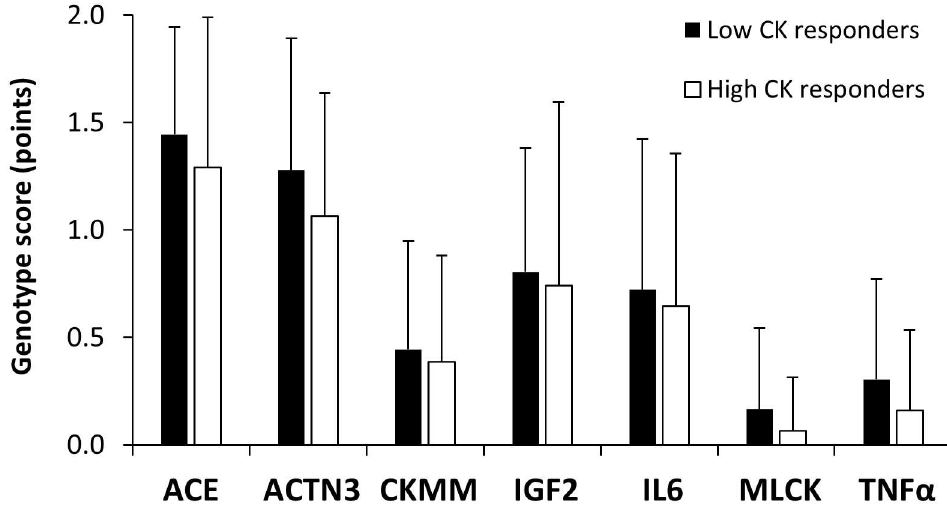
Fig 3. Individual genotype scores in low and high CK responders during a marathon competition. Data are mean ± SD.